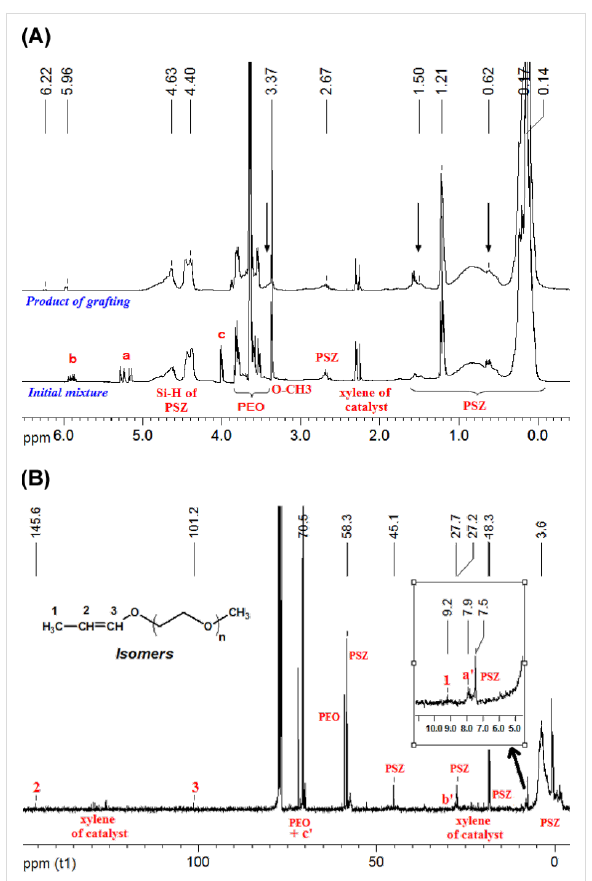
Figure 2: Identification of the grafting of PEO350 molecules onto PSZ chain. (A) Comparison of 1 H NMR spectra of initial mixture and grafting product. (B) 13 C NMR spectrum of grafting